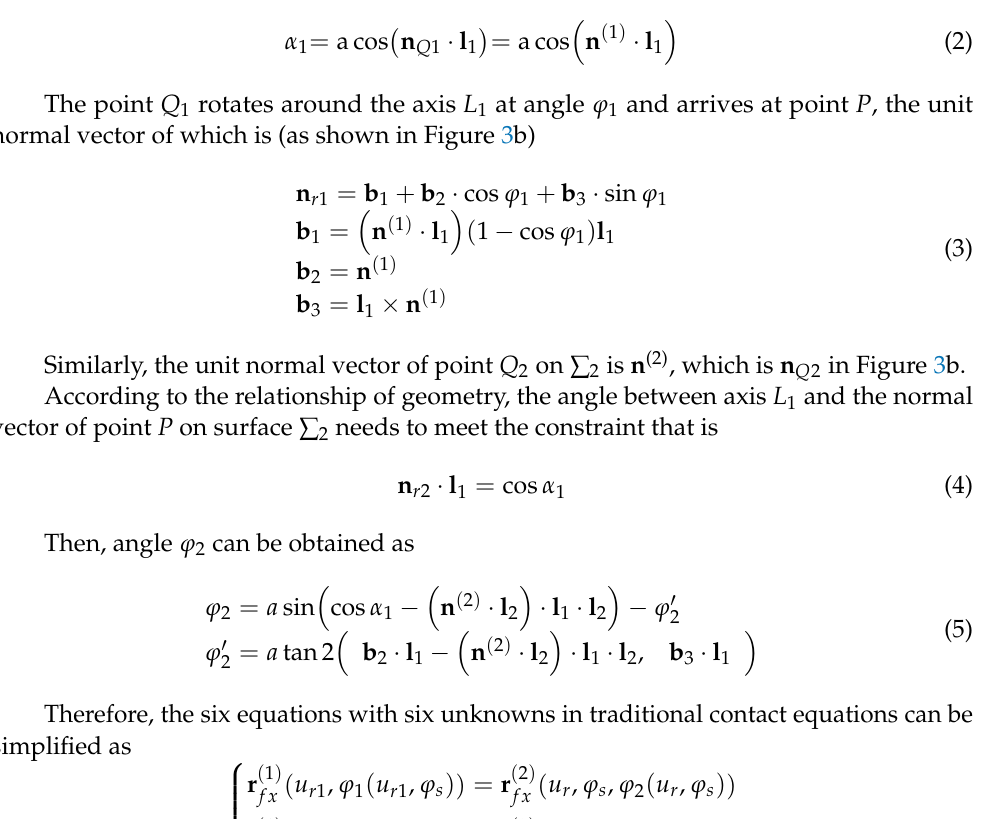
Figure 3. Geometrical relationship of the contact point: ( a ) contact point; ( b ) normal vector. The unit normal vector of point Q 1 on the pinion surface is n (1) , which is n Q 1 in Figure 3b. The angle between the normal vector and the pinion axis